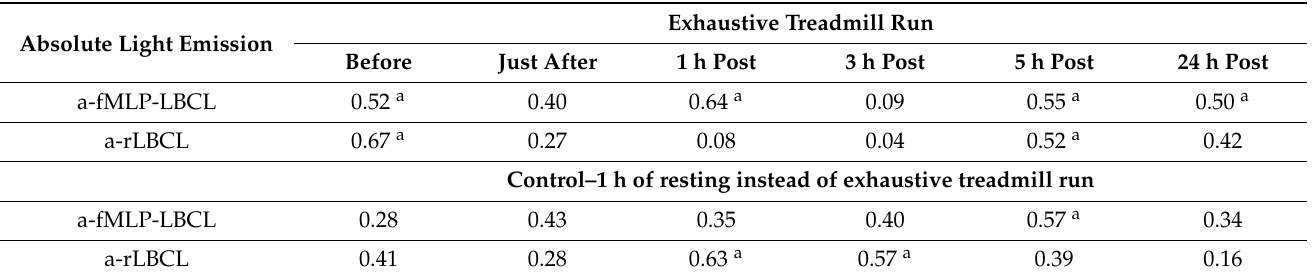
Table 9. Correlations ( δ ) between absolute rLBCL and fMLP-LBCL and the total number of gran- ulocytes in the assayed blood sample collected before, just after and at 1 h, 3 h, 5 h and 24 h post-exhaustive treadmill run.